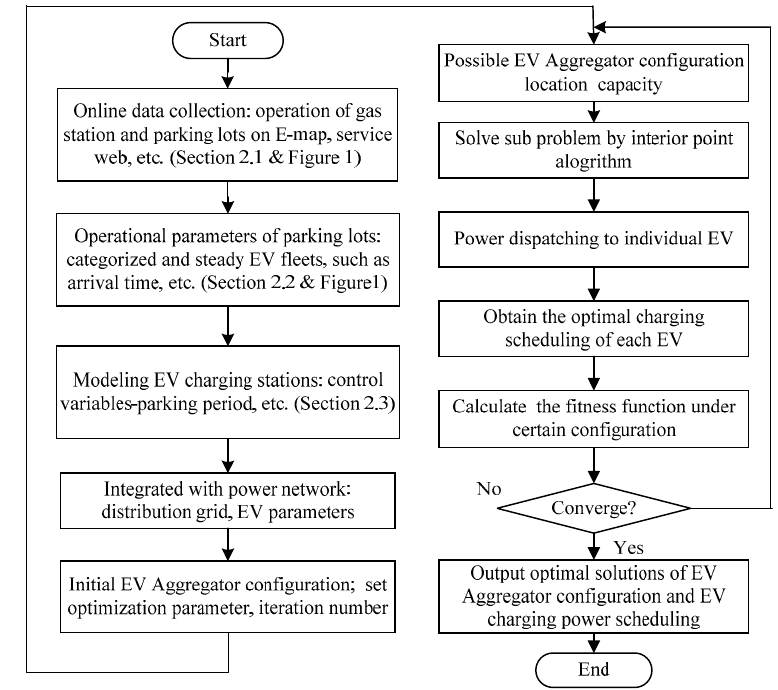
Figure 2. Flowchart of the proposed optimal control algorithm for EV charging facilities.